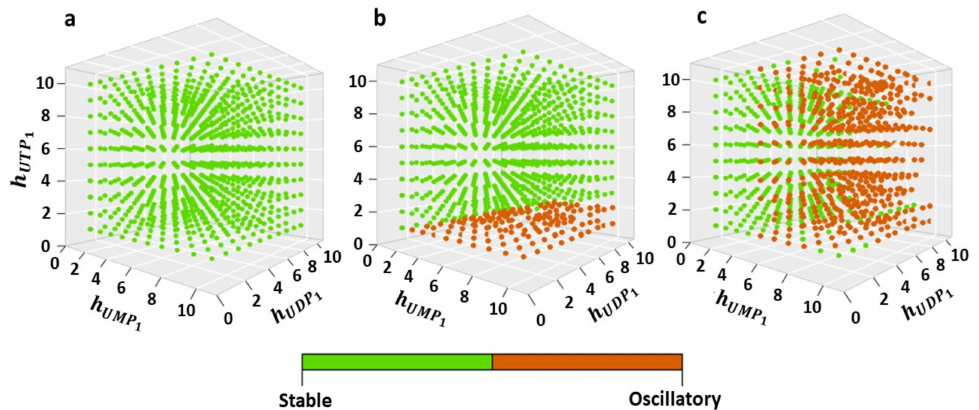
Figure 5. The dynamic state of the pyrimidine biosynthesis metabolic system determined using the Bayesian Spectrum Analysis method [30; Supplementary Text S4] in the three-dimensional space of Hill parameters ( h UMP1 , h UDP1 , h UTP1 ) at parameter value r = 1, which corresponds to noncompetitive UTP inhibition of the first pyrimidine nucleotide phosphorylation enzymatic reaction, UMP. The green dots correspond to the stationary state of the system, and the orange dots correspond to the oscillatory mode of functioning. Each of the Hill parameters was varied in increments of one. The full version of the analysis of the three model variants with variation of r = [0;1] is given in Supplementary Files